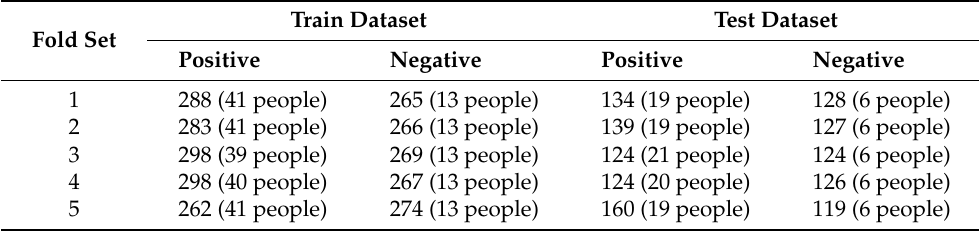
Table 1. Information on the compositions of the training and test data for each fold. Fold